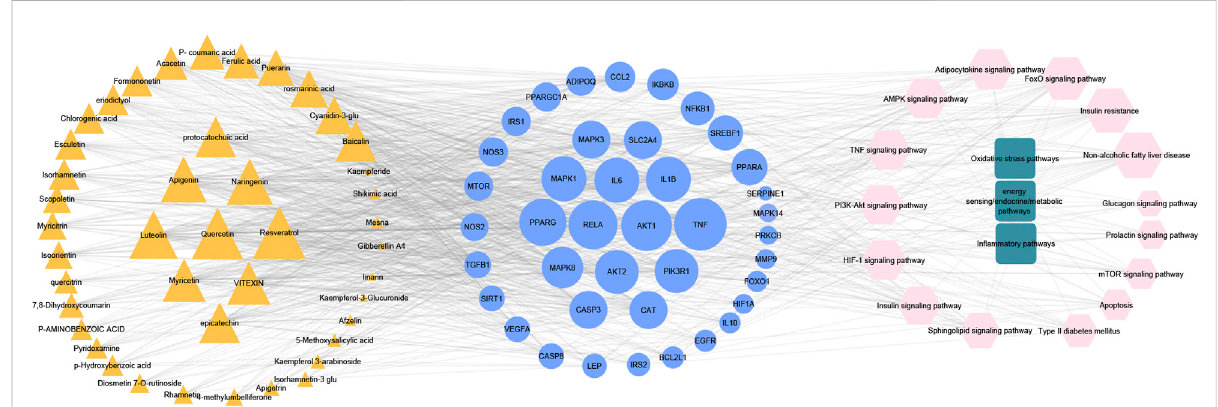
FIGURE 8 Representscompounds-corekeytargets-pathwaysnetwork.Theyellowtrianglesrepresentcompounds,thebluecirclesrepresenttargets,the pinkHexagons representpathways,andthegreensquaresrepresentcollectionsoffunctionallyrelatedpathways.Thelargerthesizeofthenode,the greater its degree. Adjusting the size of the images and resolution, adding the panels ’ letters, and combining the images was carried out using Photoshop.